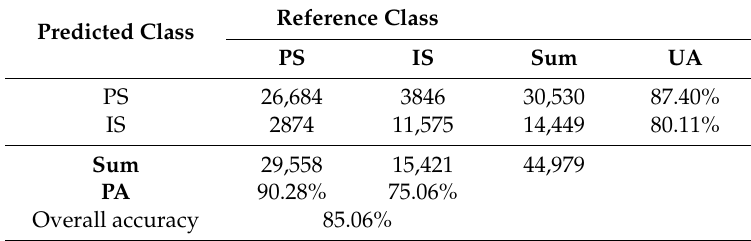
Table 1. Error matrix for the final map using our proposed feature extraction method. PA: producer accuracy, UA: user accuracy, IS: impervious surface, PS: pervious surface.